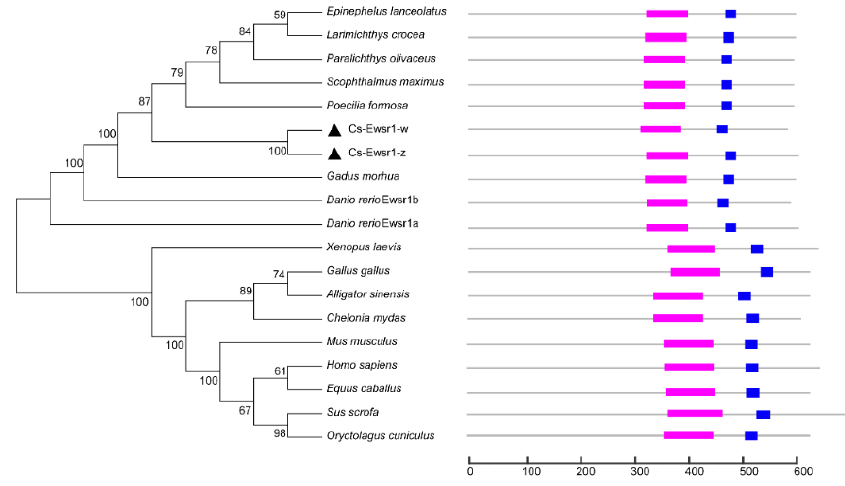
Figure 2. Phylogenetic analysis of Ewsr1 proteins in multiple species. “ ” represents RNA